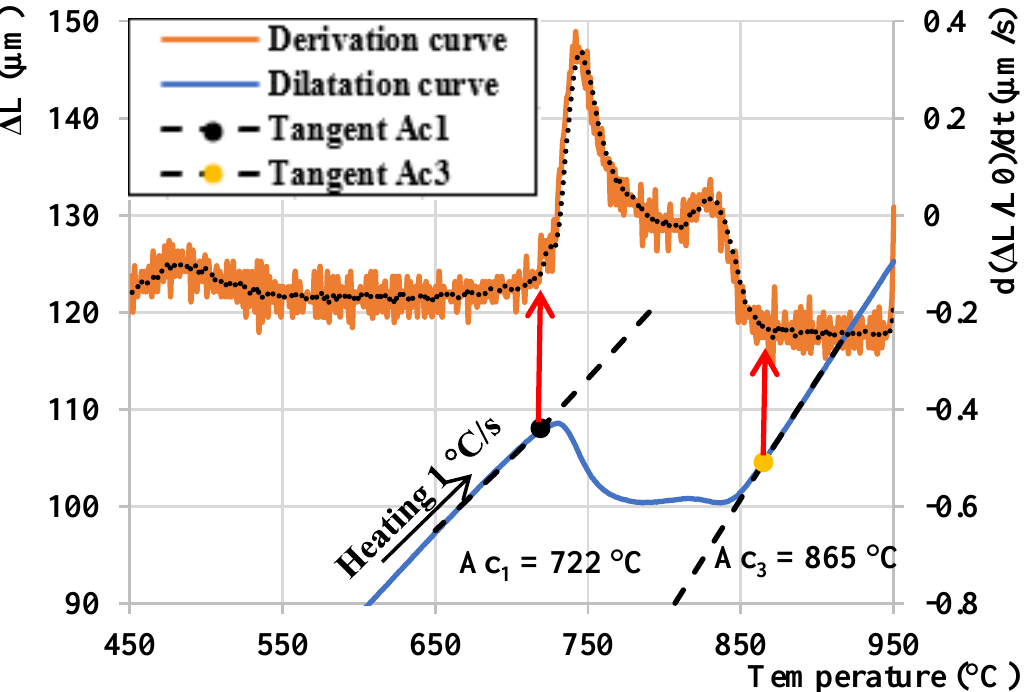
Figure 2. Dilatation curve for heating to 900 °C—determination of temperature Ac 1 and Ac 3. Dilatation curves from the austenitization temperature of 800 ◦ C, 1000 ◦ C, and 1200 ◦ C, are exemplarily presented in Figure 3a. Dilatation curves were used to determine the initial M s . Dashed lines in the figure are tangent line copying linear parts of the dilatation curves. The deflection point between the tangent line and the curve is considered as the